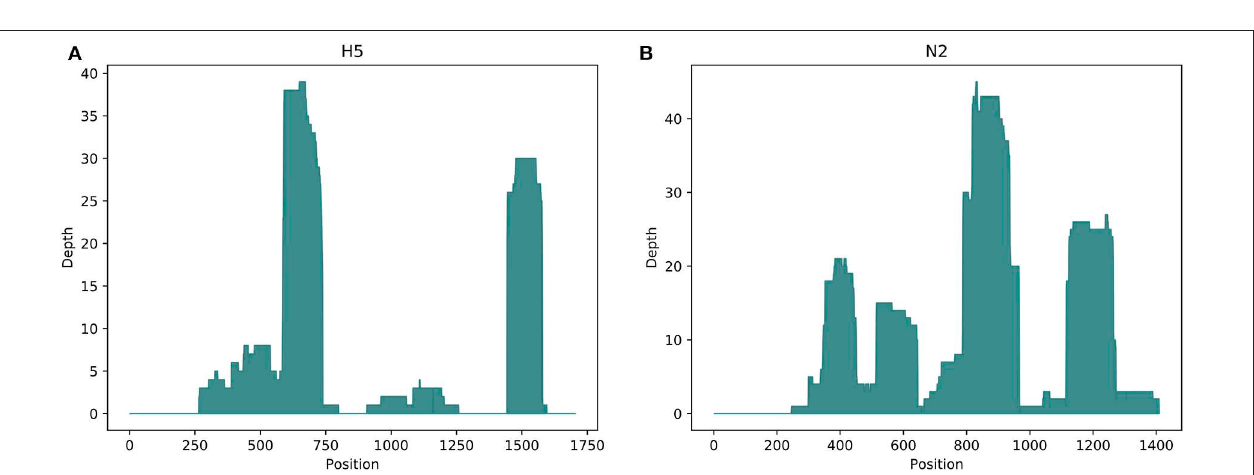
FIGURE 1 | The distribution of (A) hemagglutinin (HA) and (B) neuraminidase (NA) subtypes found in farm and wetland sediment samples.